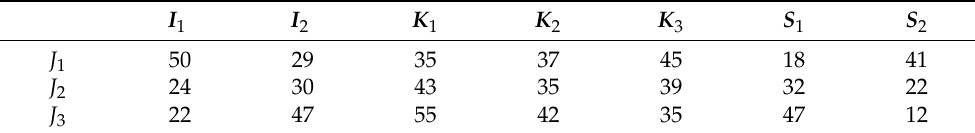
Figure 6. Paths’ Overview. Table 1. The distances between WHs, RSs, PDPs, and